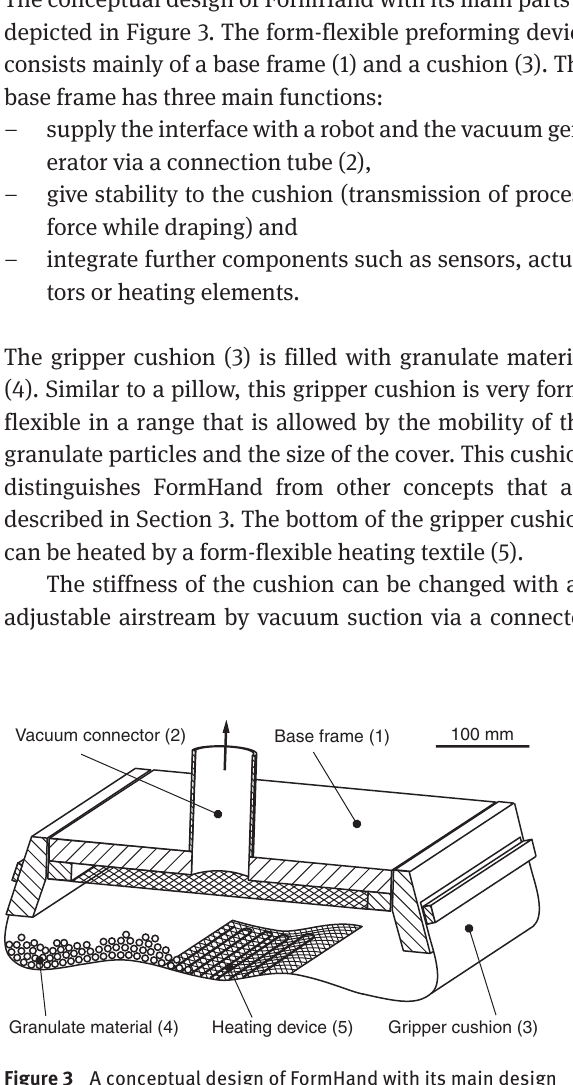
Figure 3 A conceptual design of FormHand with its main design